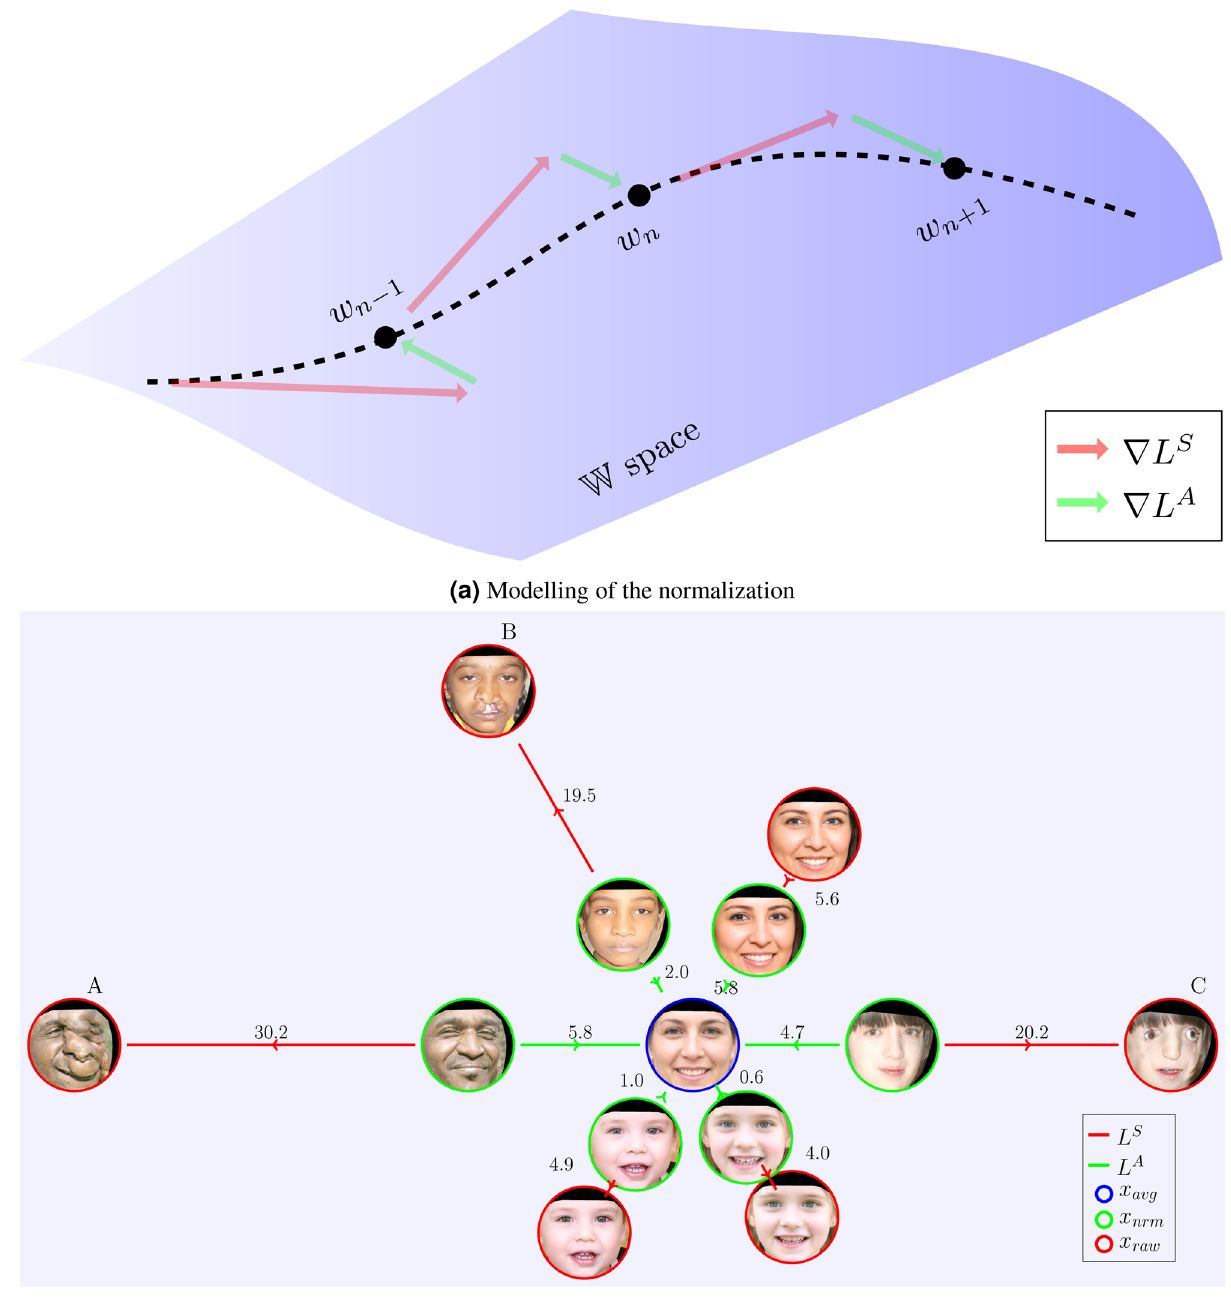
Figure 2. Visualization of the optimization represented by Eq. (1). In ( a ) modeling of the iterative normalization procedure in latent space W is depicted. The dashed curved line represents the “normal” manifold in W , and w ∗ is found along that curve by iterative updates. At each iteration i , the next latent vector w i + 1 is found by adding the gradient vector of similarity loss ∇ L S and the gradient vector of averageness loss ∇ L A to the current latent vector w . Note that L S is calculated in image space X , and gradients are back-propagated to the w . In contrast, L A is calculated in the W space, and thus gradients are calculated directly. These two conflicting gradients were calibrated in a manner that w ∗ satisfies both similarity and averageness objectives upon completion of the normalization operation. In ( b ) trade-off between image similarity loss ( L S ) and latent averageness loss ( L A ) is illustrated. We obtained x nrm (green) for each x raw (red) using our normalization algorithm. The distances between the images separated by red lines reflect the distance in image space between x raw and x nrm measured with L S perc . Similarly, the distances between the images separated by green lines reflect the distance in latent space between w raw and w avg measured with L A mse . Note that while L S attempts to produce images similar to x raw , the objective of L A is to converge upon the population average . All numbers above are multiplied by 100 for better visualization. Images A,B,C, above, correspond to references 40–42 , respectively. Images within red and blue circles, above, derive from the StyleGAN face generator 25 . All faces within green circles, above, are transformations created by the study